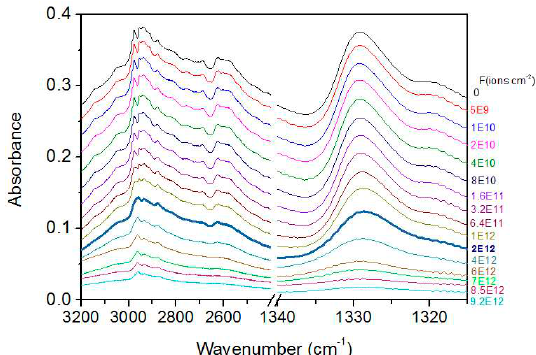
Figure 8. Absorbance decrease for the 3200–2400 and 1340–1315 cm − 1 regions, as a function of projectile fluence. The first spectrum (top) and the one marked by the thicker line correspond to the non-irradiated sample and to a fluence of 2 × 10 12 ions cm − 1 , respectively. Note the disappearance of minima at high fluences. The legend at the right side expresses fluence in ions cm − 2 .